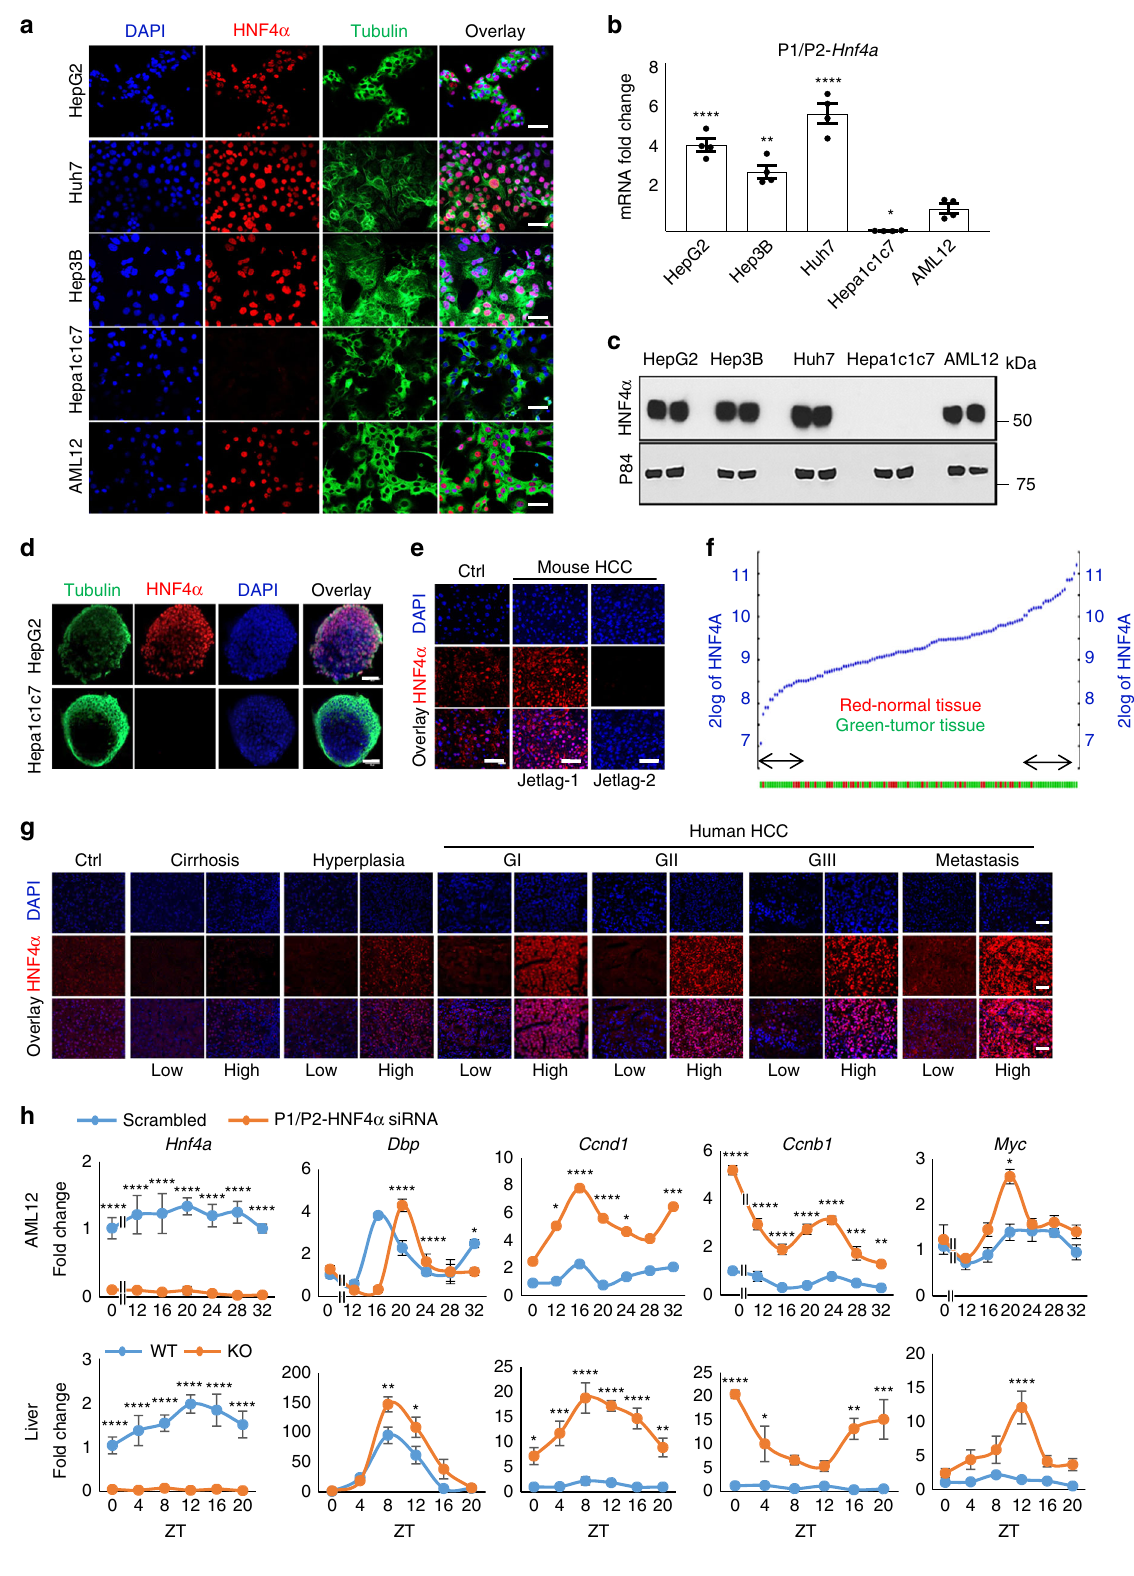
by oscillatory Dbp expression in Hepa-1c1c and Hep3B cells ( P = 0.027 and 0.004, respectively, JTK_Cycle test for rhythmicity 48 , Supplementary Fig. 1d and Supplementary Table 1). To deter- mine whether loss of HNF4 α altered the circadian expression of target genes, we treated AML12 cells with siRNA against both P1/ NATURE COMMUNICATIONS| (2018) 9:4349 |DOI: